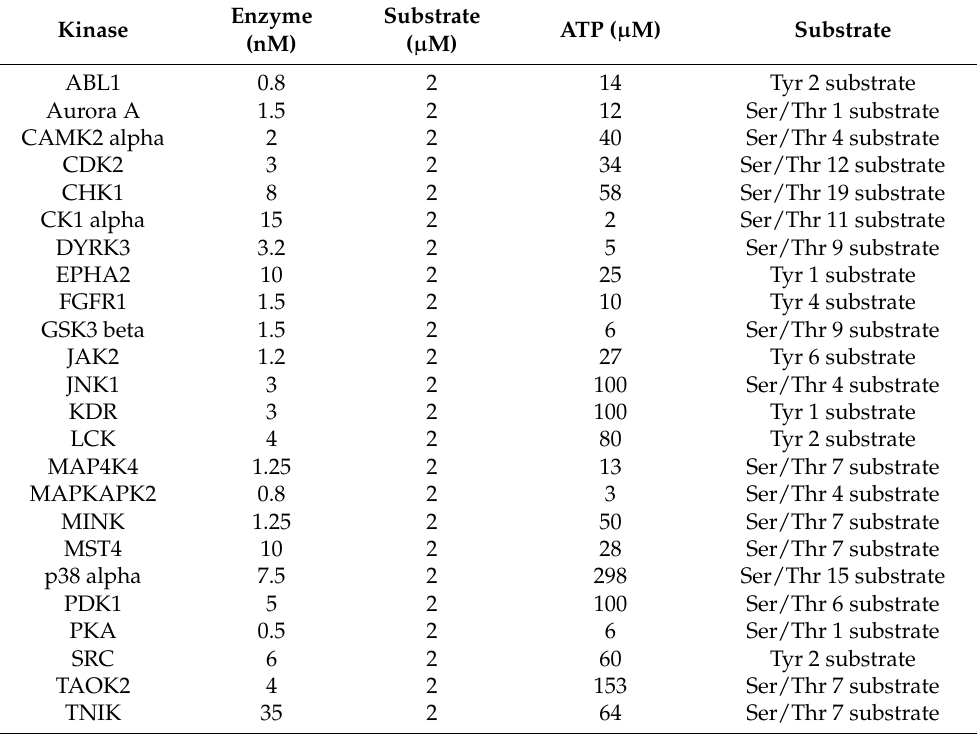
Table 4. Assay reaction conditions of ZSP1273 against 24